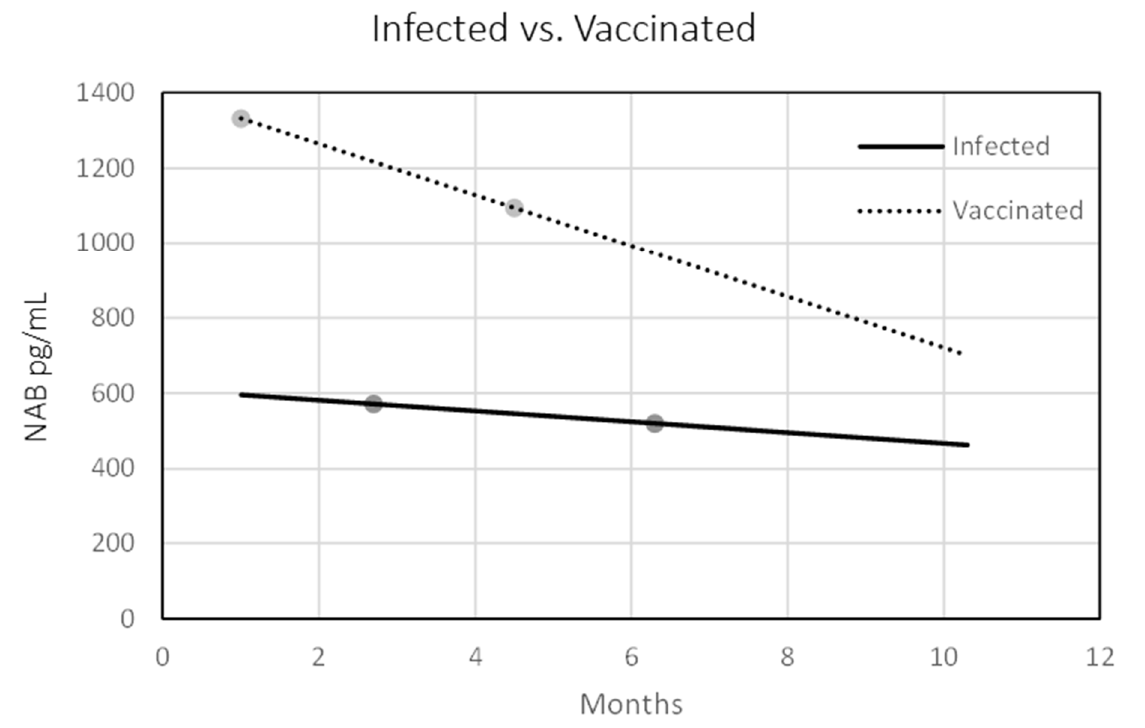
Figure 2. Scatter plot of elapsed time since second BNT162b2 vaccine dose (dotted line) and infection (continuous line) on the x-axis and NAbs titers on the y axis.